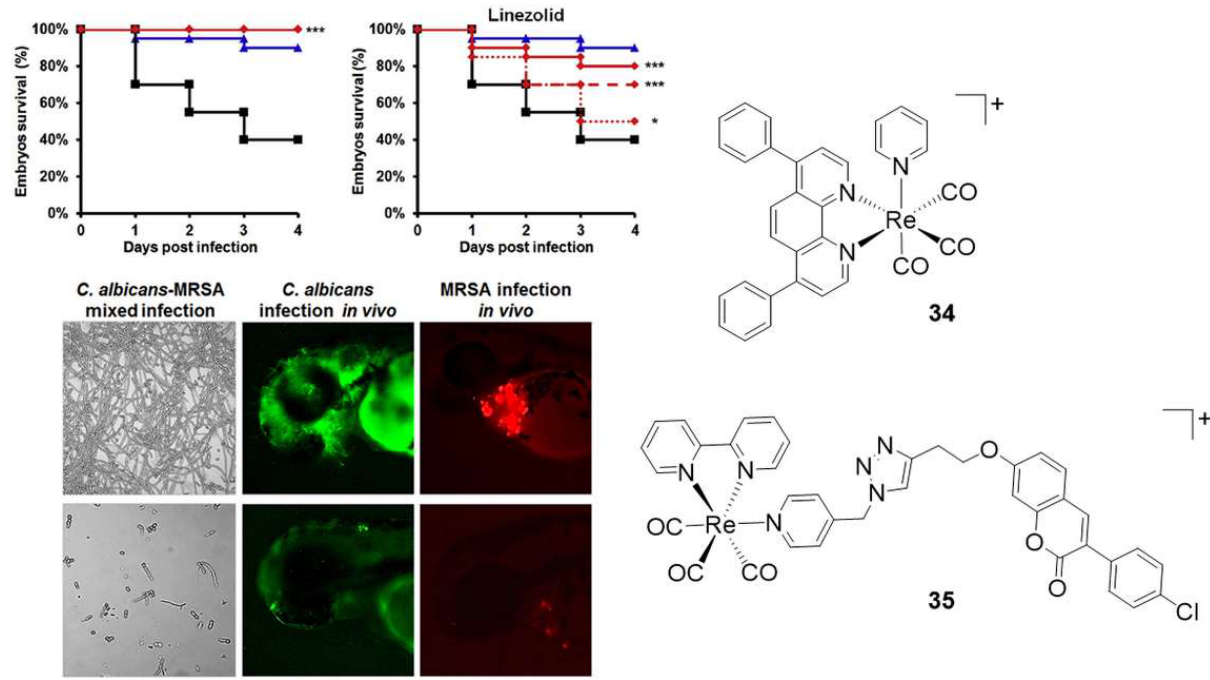
Figure 8. Top left: Kaplan–Meier survival curves of the MRSA- or C. albicans -infected zebrafish embryos treated with molecules 34 or 35 (top-left graph; molecules show identical fish survival response) in comparison with that of the approved drug Linezolid (top-right graph). In the Kaplan– Meier survival curves, the red line = ½ × MIC; blue line = non-infected control; black line = infected control; dashed red line = 1 × MIC and dotted red line = 2 × MIC. Note that in the top-left Kaplan– Meier survival curve, all red lines overlap, indicating that 34 and 35 are safe and non-toxic at all tested concentrations (i.e., all MIC values). Bottom left: in vitro and in vivo antimicrobial effects of molecule 34 in C. albicans –MRSA mixed infections; lethal C. albicans infection and lethal MRSA infection. The green and red fluorescence intensity of labelled microbes (as a measure of infection burden) is markedly reduced upon treatment with 34 . Asterisks stand for statistical significance in the survival rates between treated and untreated embryos (* p < 0.05; *** p > 0.001). Figure readapted with permission from publisher [98] .